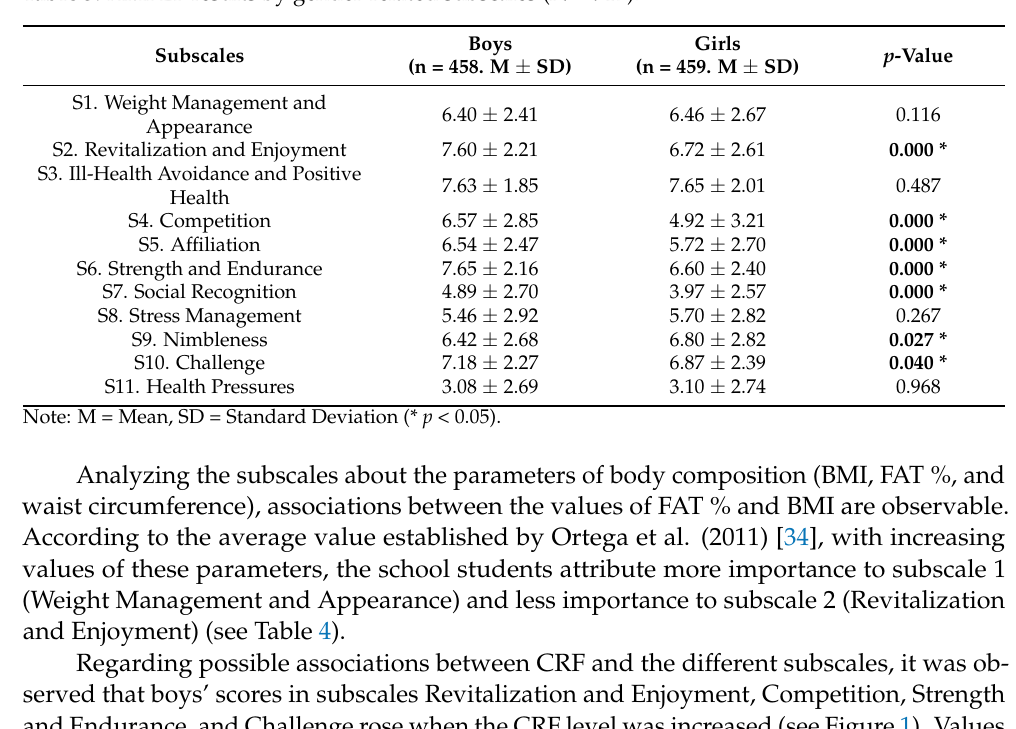
Table 3. AMPEF results by gender-related subscales (N =